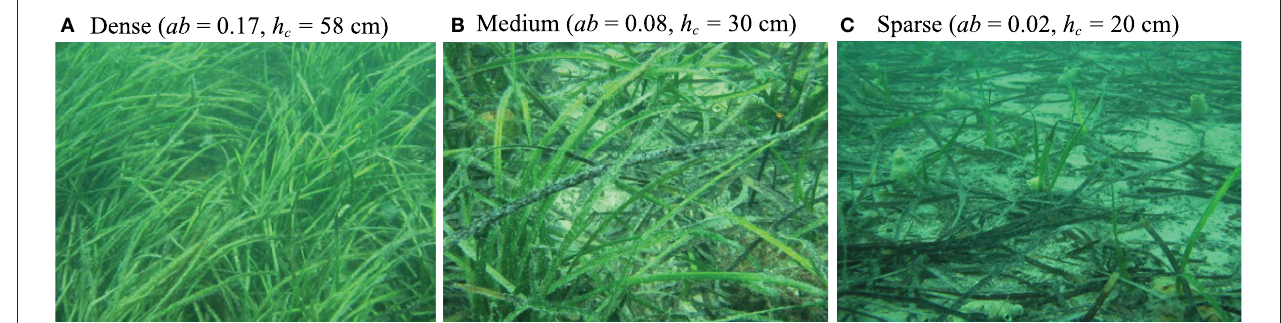
FIGURE 2 | Pictures showing varying canopy density due to imposed light level in meadows of Posidonia sinuosa seagrass, located at Jurien Bay, Western Australia. Increasing shading (from A–C ) reduced canopy density and height (data and pictures from Collier et al., 2009).